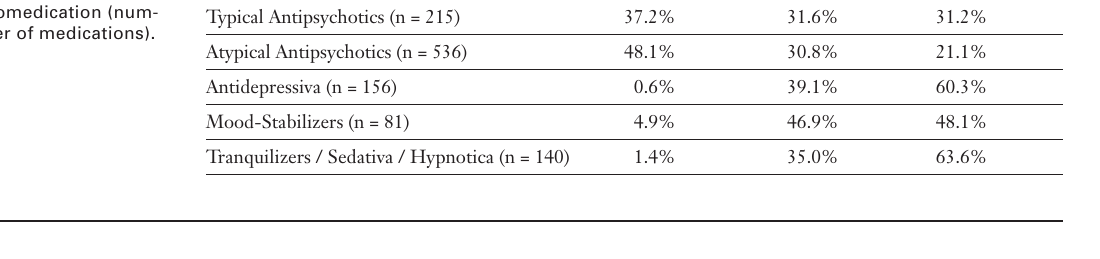
Comedication (num- ber of medications).